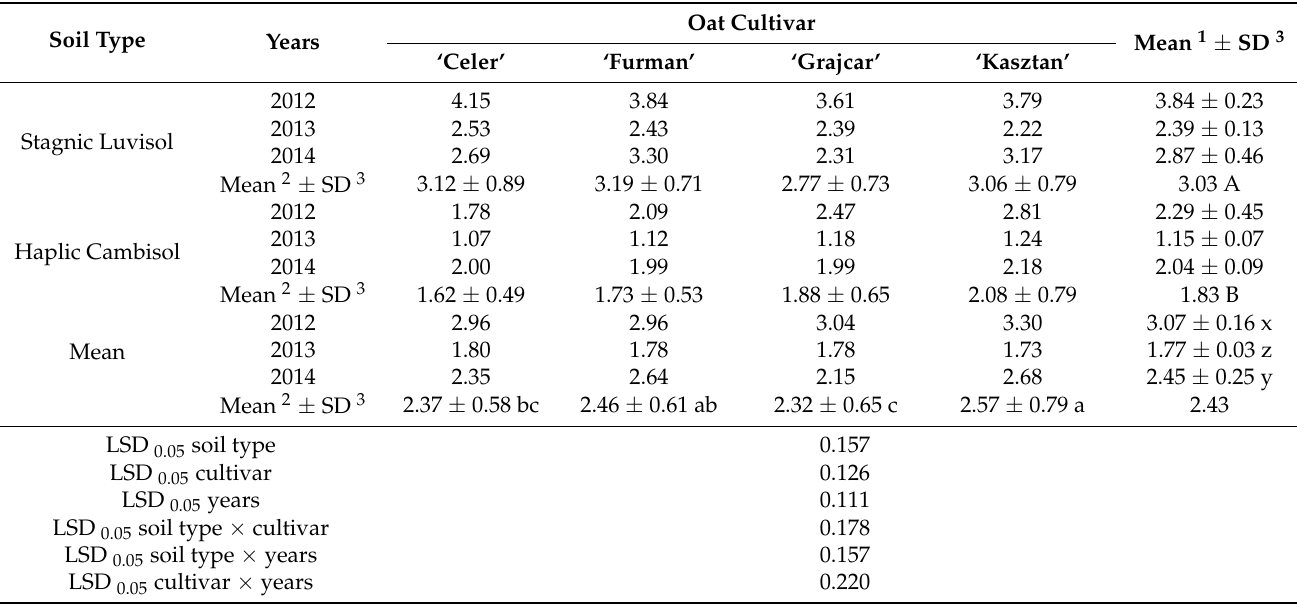
Table 7. Seed yield (t ha − 1 ) of the mixture depending on the soil type (factor I), oat cultivar (factor II), and study years (factor III).